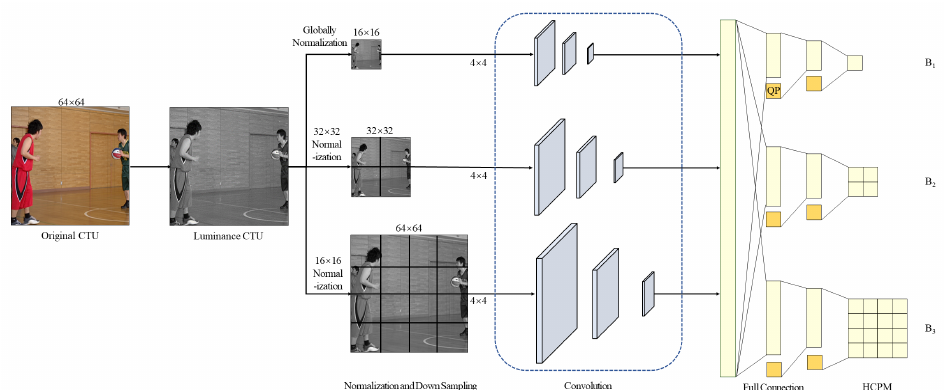
Figure 5. The structure of CNN. The network mainly includes three parts, pre-process, convolution, and decision making. The CTU are demeaned and down-sampled to reduce the computation time in pre-processing, the convolution includes 3 convolutional layers and an fc layer to extract image features, and the decision-making part judges the CU partition to HCPM by